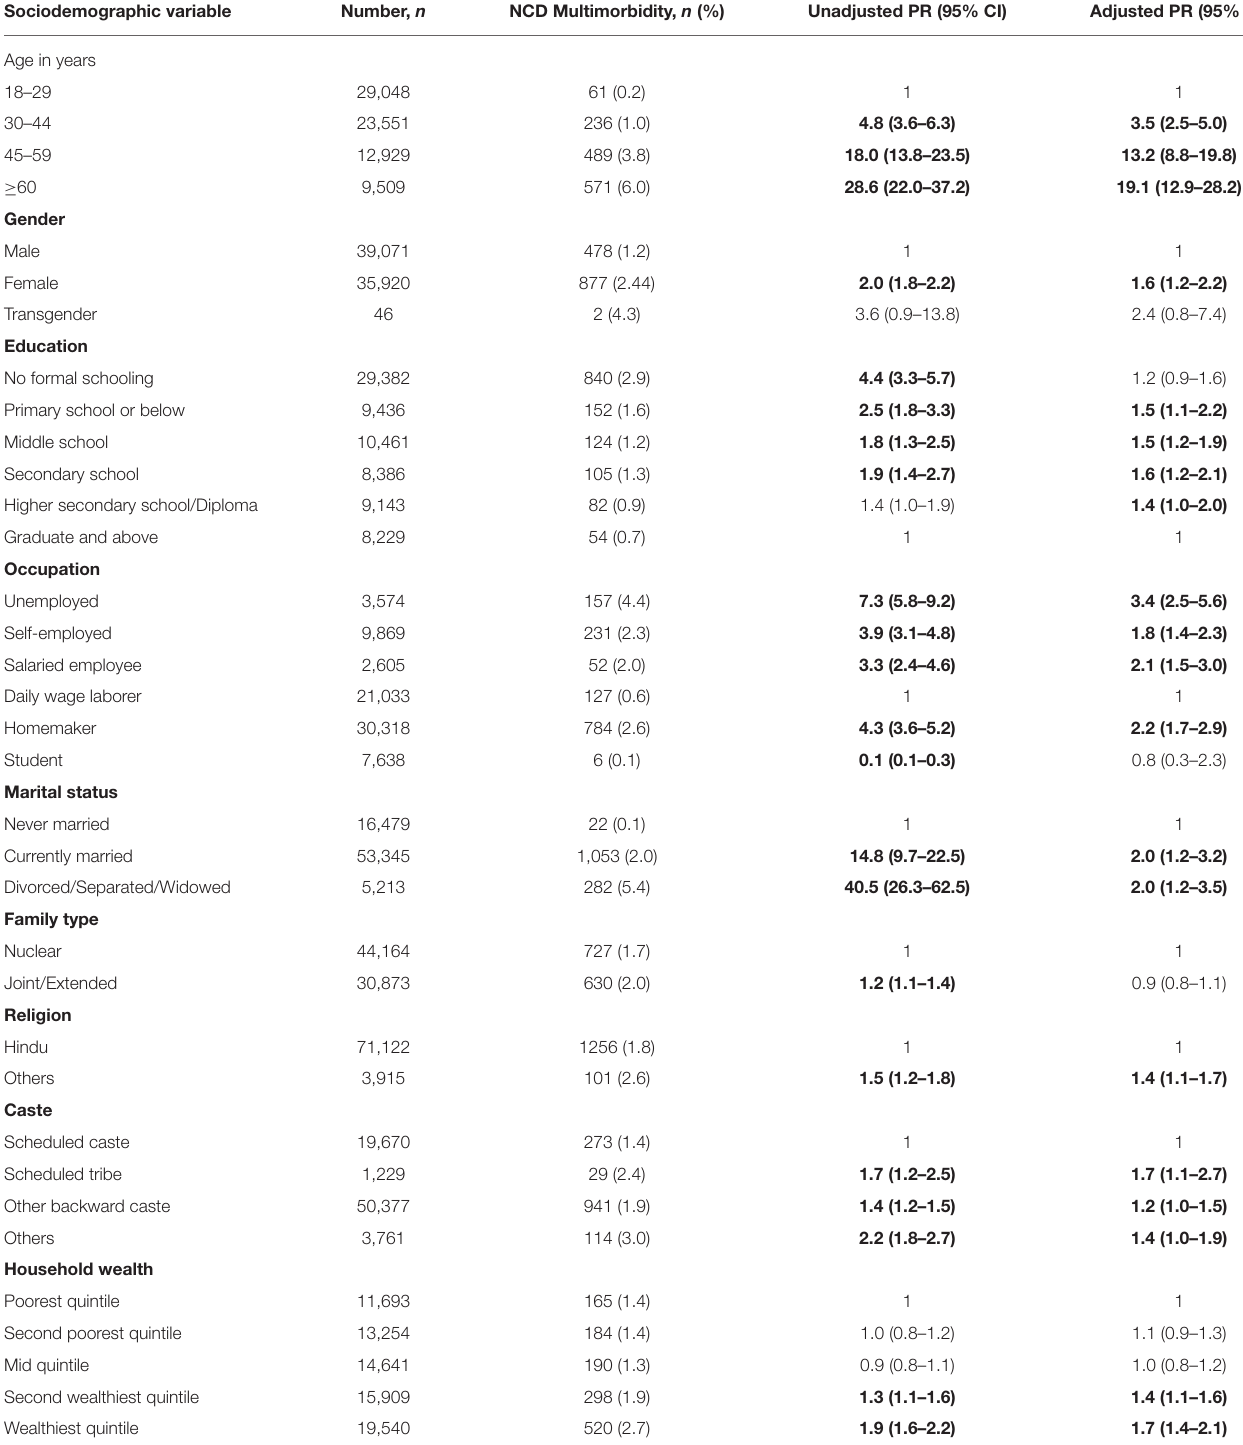
TABLE 2 | Factors associated with NCD multimorbidity among adults residing in HDSS, Gorakhpur ( N = 75,037). Sociodemographic